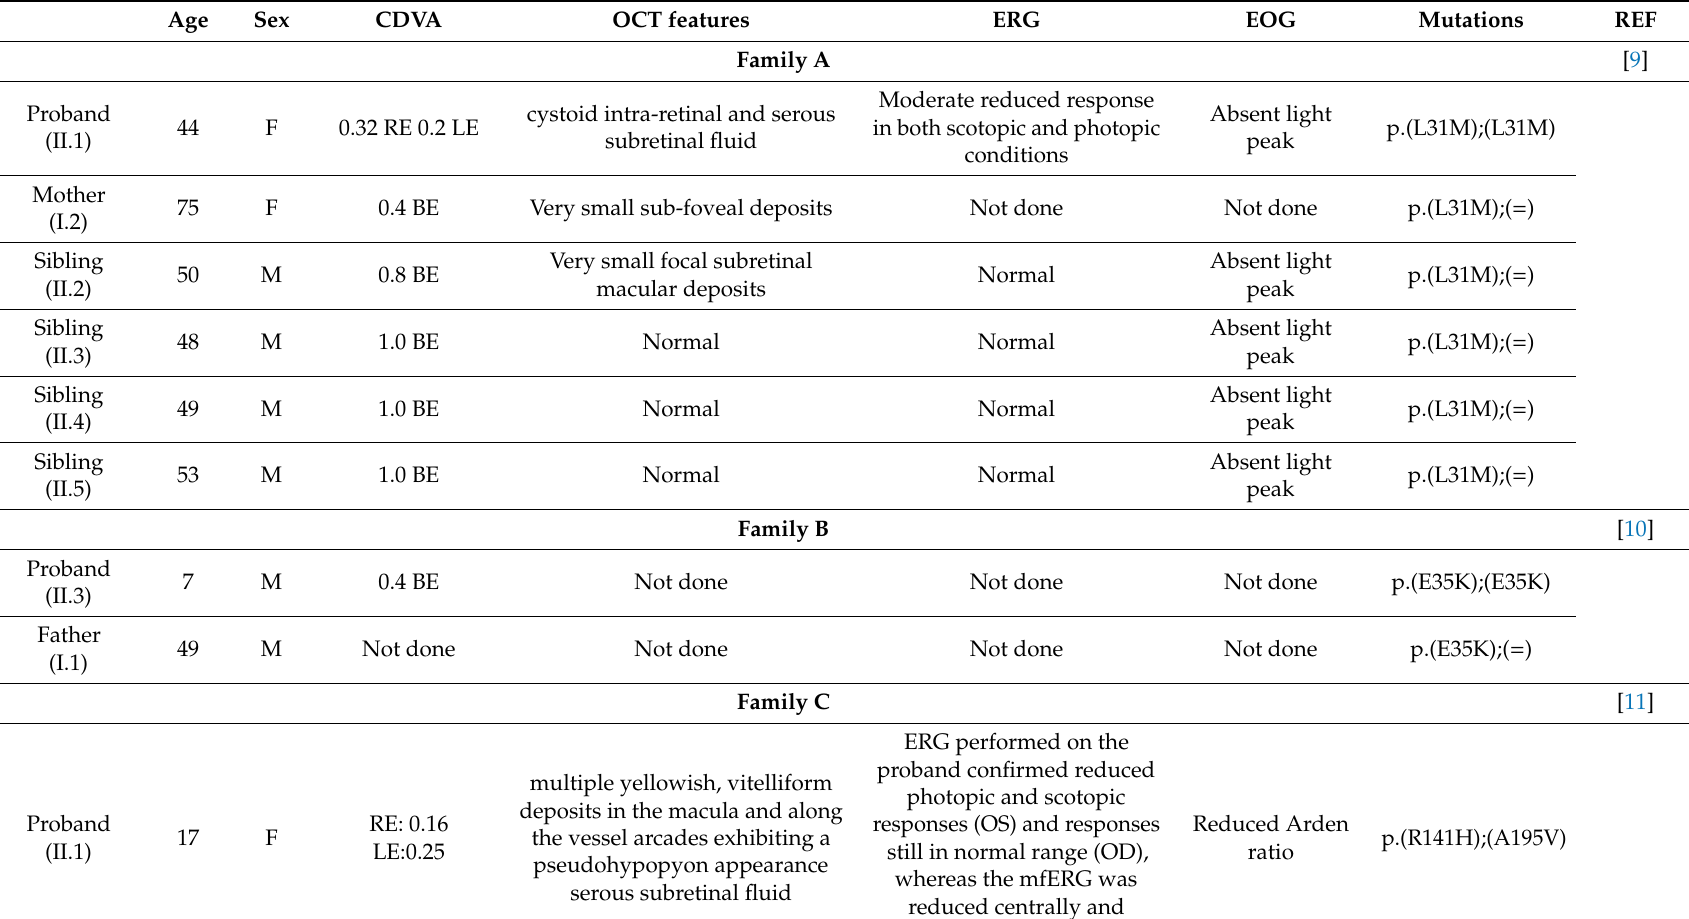
Table 1. Summary of the clinical